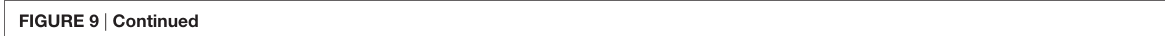
FigUre s1 | Phenotypic analysis of eosinophils (eOs) freshly separated from healthy non-atopic donors . (a) EOs were purified from peripheral blood of healthy non-atopic donors. The purity of EOs was confirmed by analyzing the phenotype of cells obtained after separation. In particular, EOs expressed omogeneously the phenotype CD16 − /2B4 + /NTBA + (left panel), while neutrophils expressed omogeneously the phenotype CD16 + /2B4 − /NTBA − (right panel). Dead cells were defined as Annexin V + /ToPro3 + cells, thus cytofluorimetric analysis of EOs was always performed by gating on Annexin V − /ToPro3 − cells. (B) EOs were assessed by flow cytometric analysis for a number of surface molecules by gating on AnnexinV − /ToPro3 − cells. The phenotypic analysis of neutrophils was used for comparison. The data shown in the table were obtained from the analysis of 20 different healthy donors. FigUre s2 | analysis of survival and activation of eosinophils (eOs) purified from healthy non-atopic donors after culture in the presence of selected cytokines . (a) EOs were cultured in the absence or in the presence of cytokines (IL5, GM-CSF, IFN γ , TNF α , IL12, IL15), then harvested and assessed by flow cytometric analysis for survival markers such as Annexin V and ToPro3. The percentage of Annexin V − /ToPro3 − EOs is indicated for one representative donor out of 30 analyzed. (B) EOs were cultured in the absence or in the presence of cytokines (IL5, GM-CSF, IFN γ , TNF α , IL12, IL15), then harvested and assessed by flow cytometric analysis for the expression of CD69 surface molecules by gating on Annexin V − /ToPro3 − cells. The bars indicate the percentage of CD69 + EOs. The average of 20 independent experiments is shown (% ± SD). * P < 0.05; ** P < 0.01. P value was obtained by comparing the conditions in the presence of the different cytokines with the condition in the absence of cytokines